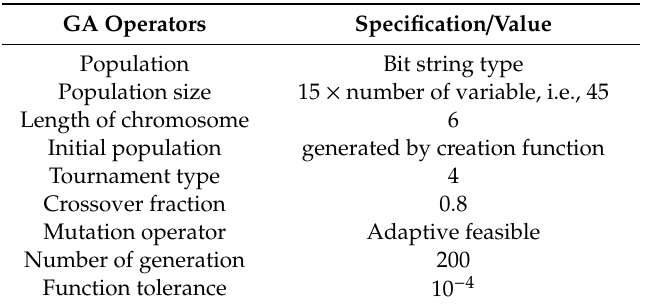
Table 12. Selected GA operators.